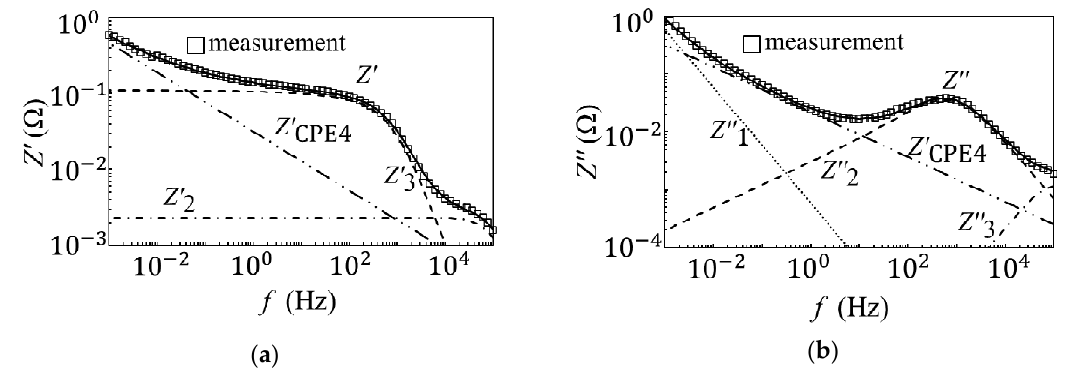
Figure 5. The equivalent circuit analysis of the degraded EDLCs. ( a ) The equivalent circuit analysis results for the real part capacitance of the degraded EDLCs. ( b ) The equivalent circuit analysis results for the imaginary part capacitance of the degraded EDLCs.